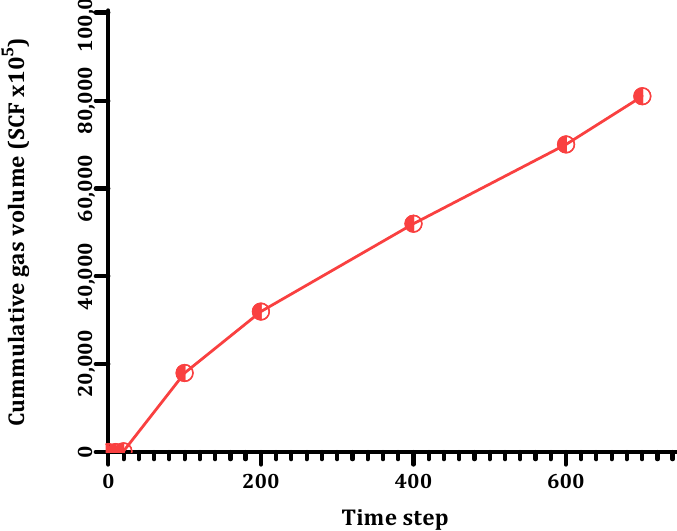
Figure 7. Barnett Shale cumulative gas production volume over 18 years.